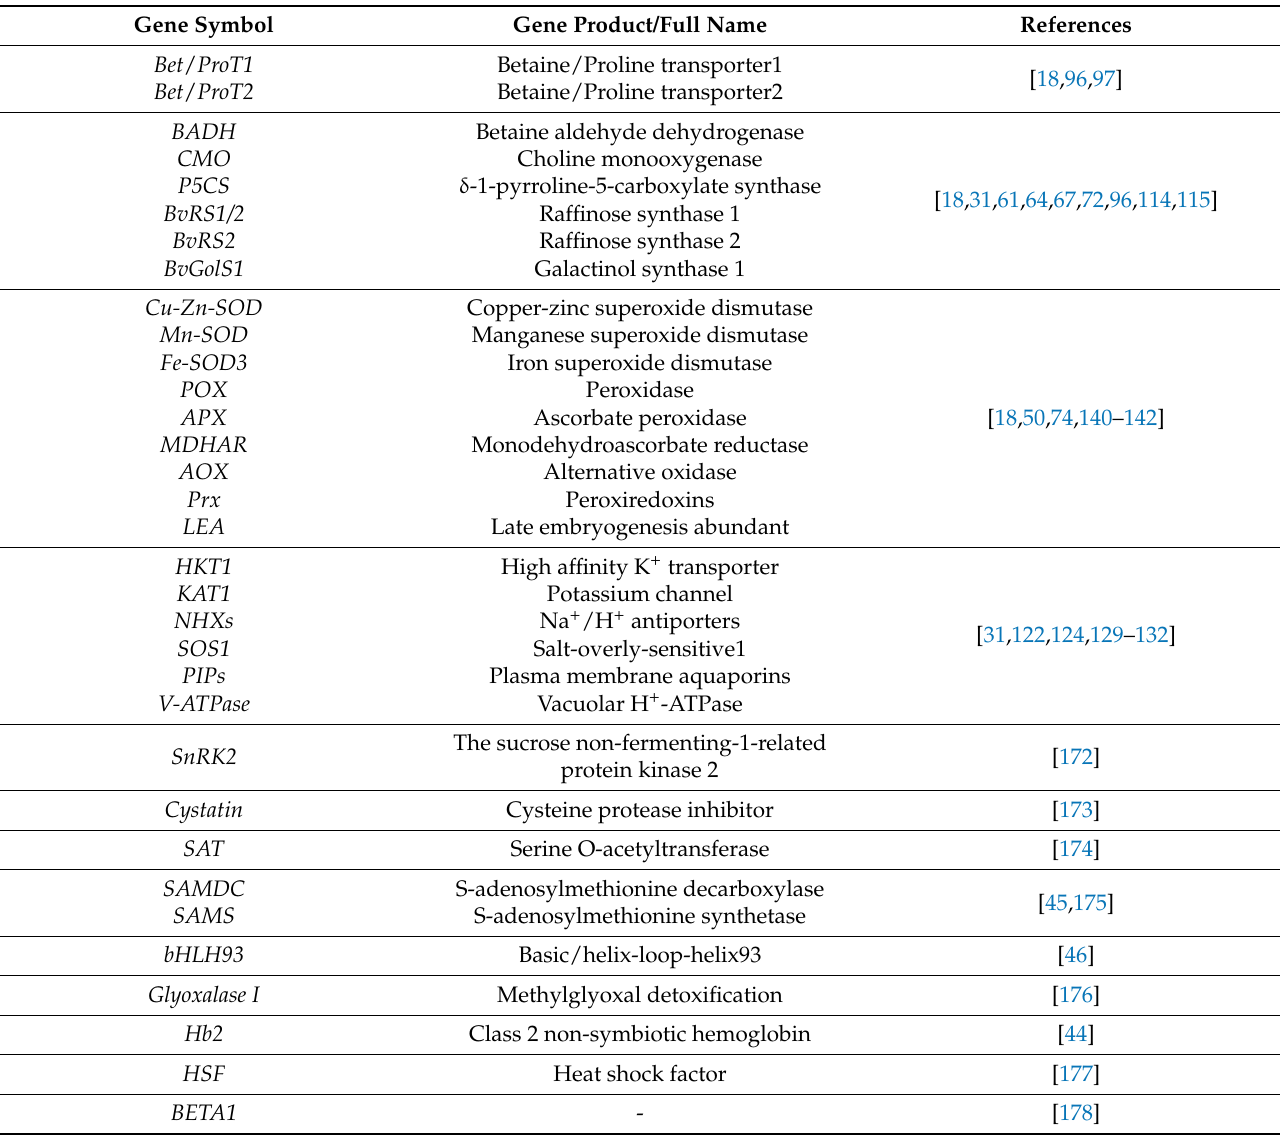
Table 2. List of beet genes involved in salt- and drought-stress response. Gene